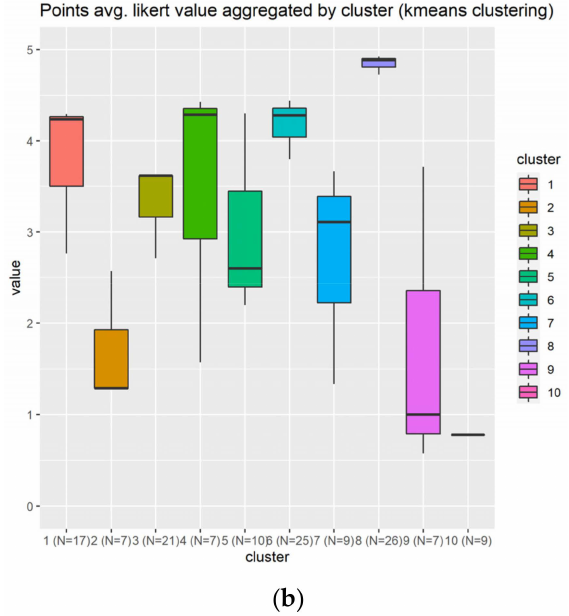
Figure 11. Points results indicate a heterogeneity of opinions; many users replied positively to those questions, as indicated in subplot ( a ). The boxplot ( b ) shows a big IQR in 6 out of 10